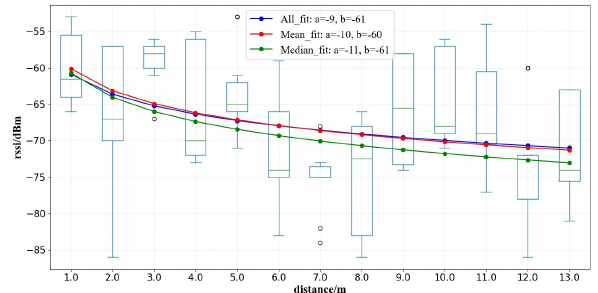
Figure 1: The collected data are used to fit the signal propagation